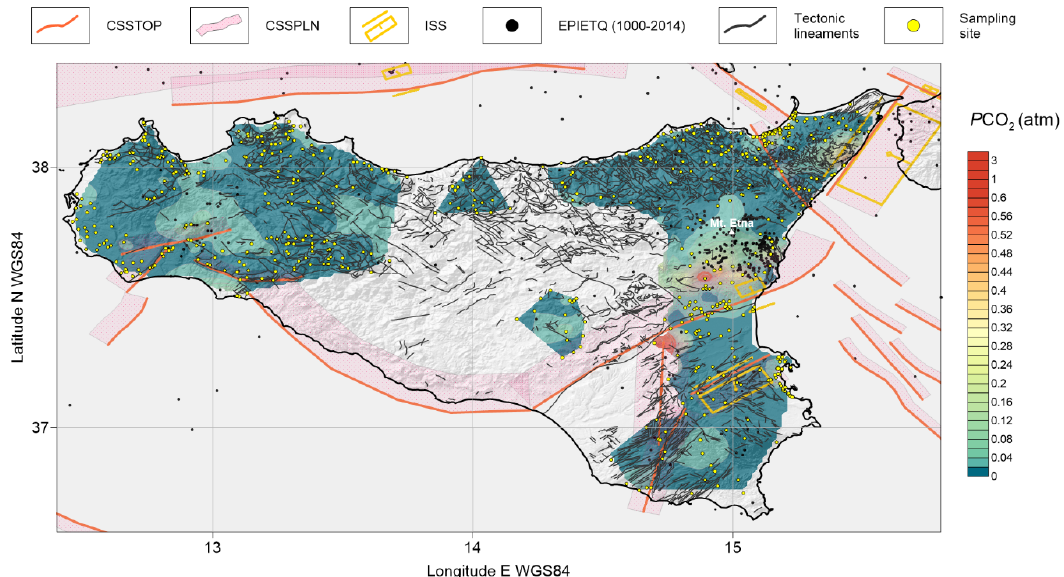
Figure 6. Combination of CO 2 dissolved partial pressure distribution, historical earthquakes (grey circles, EPIETQ) taken from the “Catalogo Parametrico dei Terremoti Italiani, versione CPTI15 [53], top traces of composite seismogenic sources (CSSTOP), dipping plane of composite seismogenic sources (CSSPLN), individual seismogenic sources (ISS) taken from the Database of Individual Seismogenic Sources (DISS, Version 3.2.1, [62]), and tectonic lineaments (from [63]).